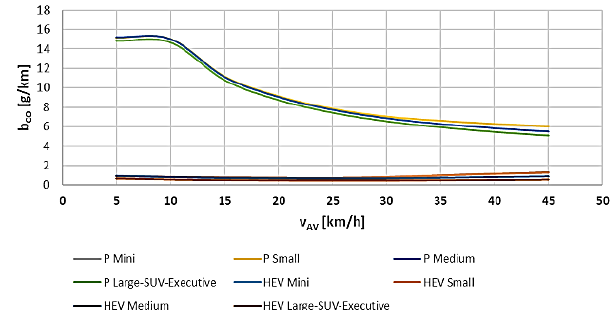
Fig. 33. CO emission from petrol PCs for vehicle segments depending on average